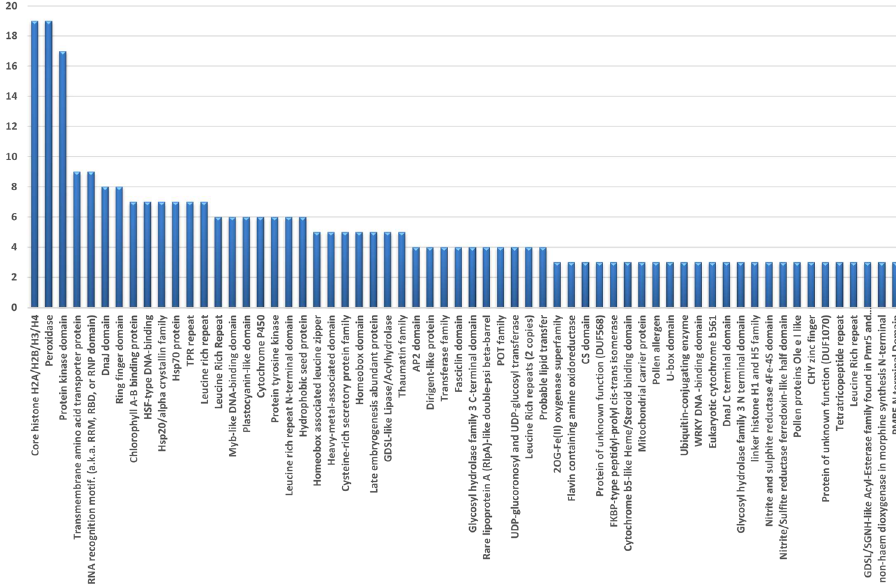
Figure 5. The summary of gene families represented in differentially expressed